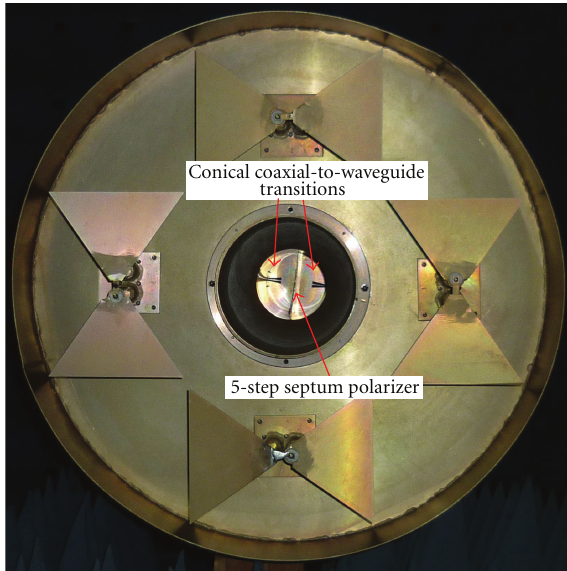
Figure 9: Feed prototype at the ERA anechoic chamber, front view (note 2320 MHz section).